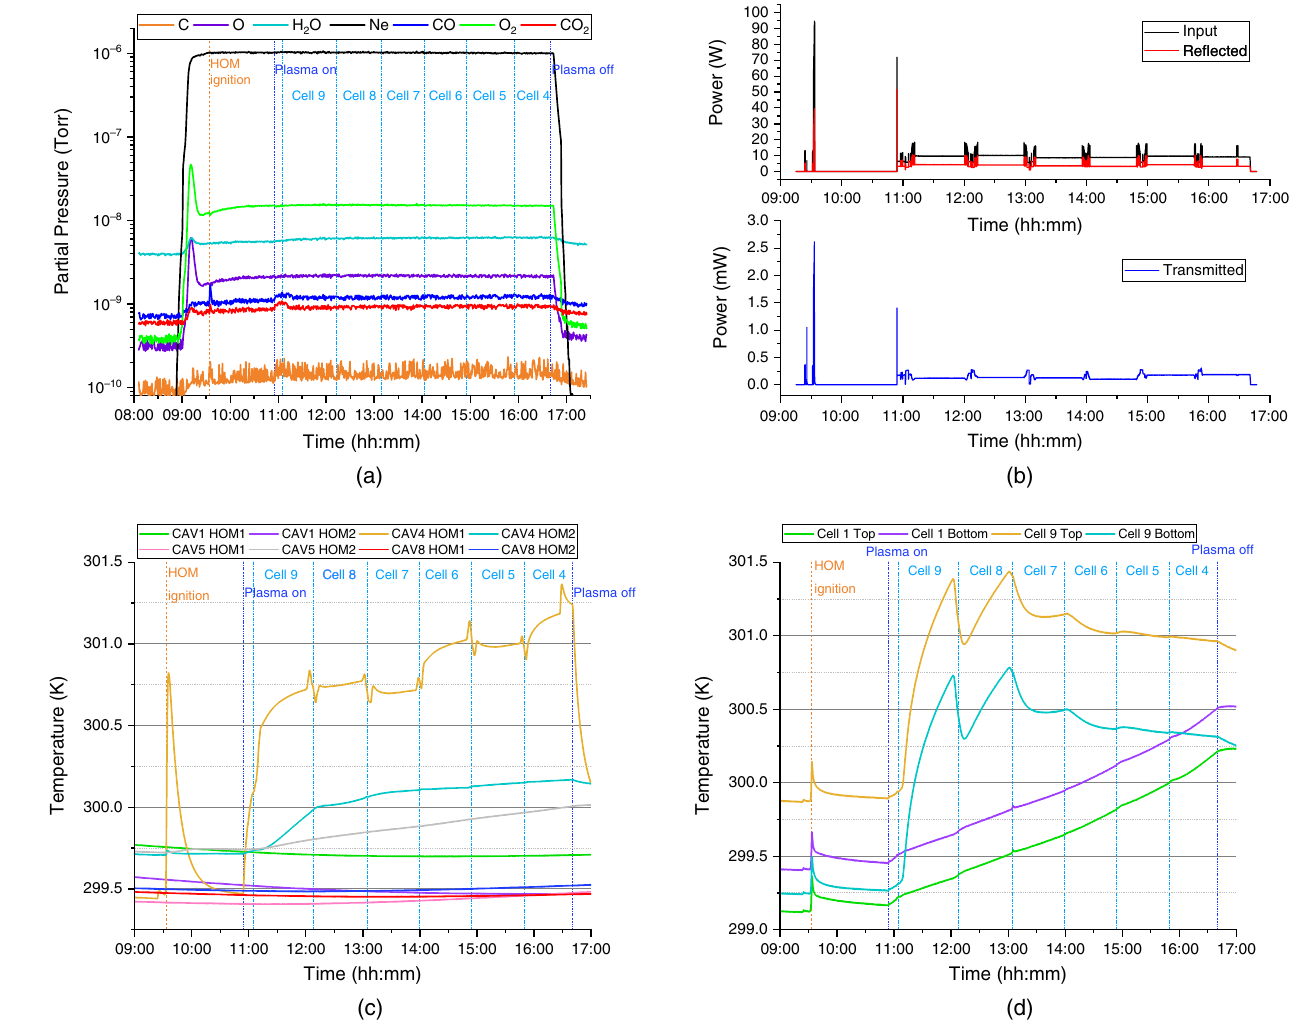
FIG. 8. Experimental data collected during plasma processing of CAV4. (a) contains a plot of the RGA signals measured during plasma processing of cells no. 9 to no. 4. The peak at approximately 9 ∶ 30 measured for CO and CO 2 indicates the accidental ignition of the plasma in the HOM coupler. The following peak at approximately 11 ∶ 00 is measured when the plasma is successfully ignited inside the cavity. (b) shows the input and reflected power measured at the CAV4 HOM1 coupler and transmitted by the HOM2 during plasma processing. Note the different scales on the y axis between the top and bottom plots. Additionally, in this case, the 9 ∶ 30 peak corresponds to accidental HOM ignition, while the next peak corresponds to the ignition of the plasma in the cavity, followed by a rapid sequence of smaller intensity peaks that identify the plasma being moved from cell no. 5 to no. 9 and then tuned in cell no. 9. After approximately 1 h, the plasma density is decreased, and the glow discharge is moved to the next cell. This procedure is repeated for each cell. The temperature increase measured on the HOM1 and HOM2 connectors of all four plasma-processed cavities is shown in (c). In the period plotted here, the glow discharge was ignited in CAV4, as confirmed by the temperature increase registered by its HOM1 and HOM2 sensors. (d) shows the temperature increase measured on the outside of cells no. 1 and no. 9. The four sensors are placed inside the He vessel at the top and bottom of the end